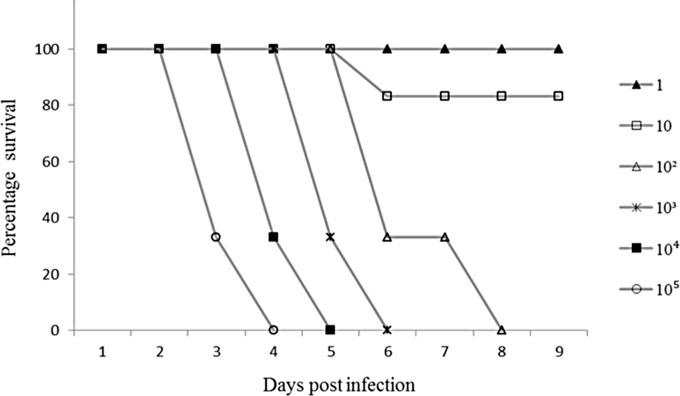
LD50 study: Survival graph of 2-week-old hamsters orally infected with six different viral doses (1−105 CCID50).Each group comprised 6 animals. All animals infected with the 1 CCID50 dose survived.